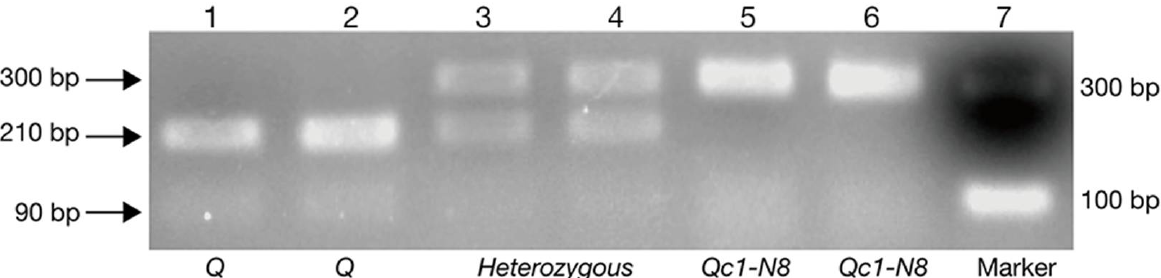
Figure 7. Gel separation of digested and undigested PCR products amplified by using the primer pair N8-CAPS-F1 + N8-CAPS-R1. Lanes 1 and 2 are the digested results of the Q allele. Lanes 3 and 4 are the digested results of the Q / Q c1 -N8 alleles. Lanes 5 and 6 are the undigested results of the Q c1 -N8 allele. Lane 7 is the DNA marker. Table 3. Primers used in this study.